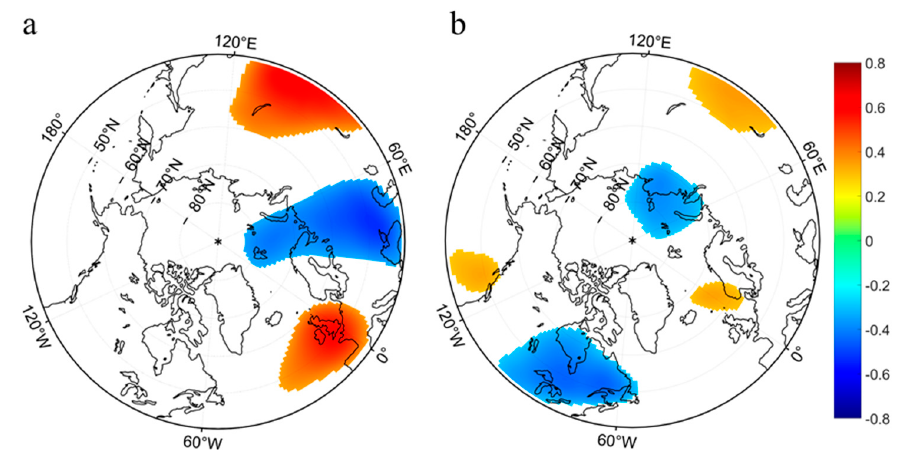
Figure 8. ( a ) The correlation coefficient distribution between the winter Arctic Oscillation and November 500 hpa geopotential height; ( b ) the correlation coefficient distribution between the November Barents–Karas sea ice concentration index and November 500 hpa geopotential height. The colored regions passed the t-test with a confidence level of 95%. All of the series have been detrended.